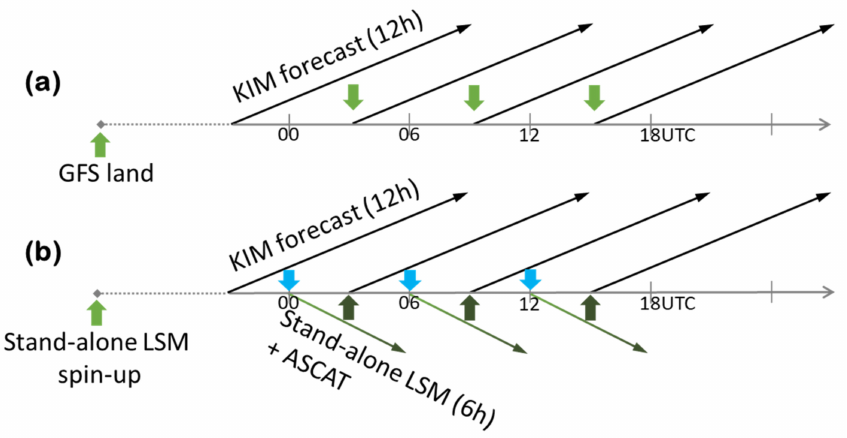
Figure 4. GDAPS-KIM soil moisture initialization system ( a ) without and ( b ) with soil moisture data assimilation.